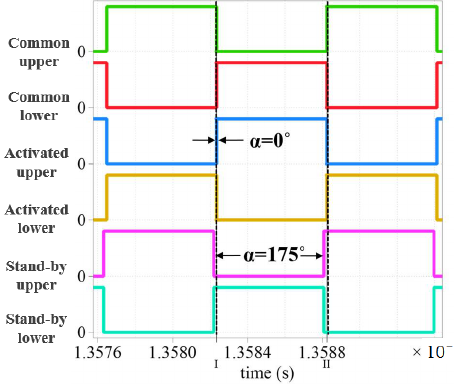
Figure 5. Driving signals for multiple legs inverter [21].